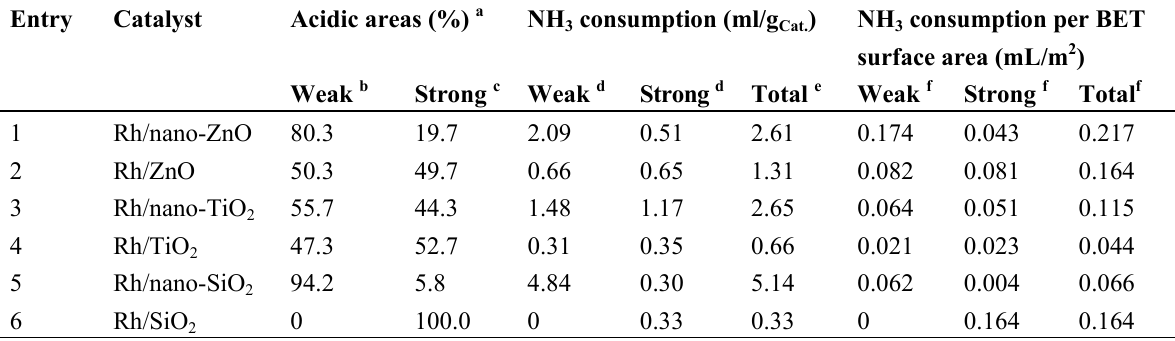
Table 2. Acidic surface areas, NH areas of Rh based